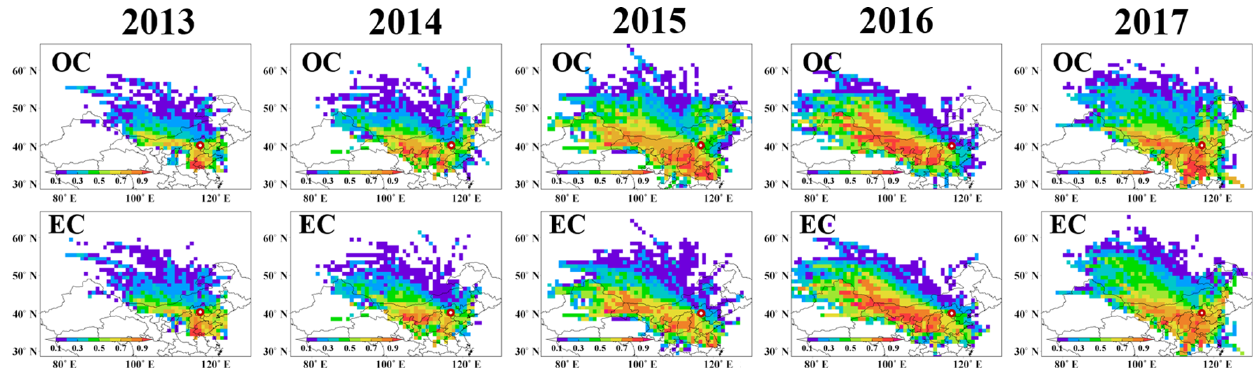
Figure 9. Potential source areas for OC and EC in Beijing from 2013 to 2017. The colour code denotes the PSCF probability. The measure- ment site is indicated with a red circle. The identification of the provinces is given in Fig.